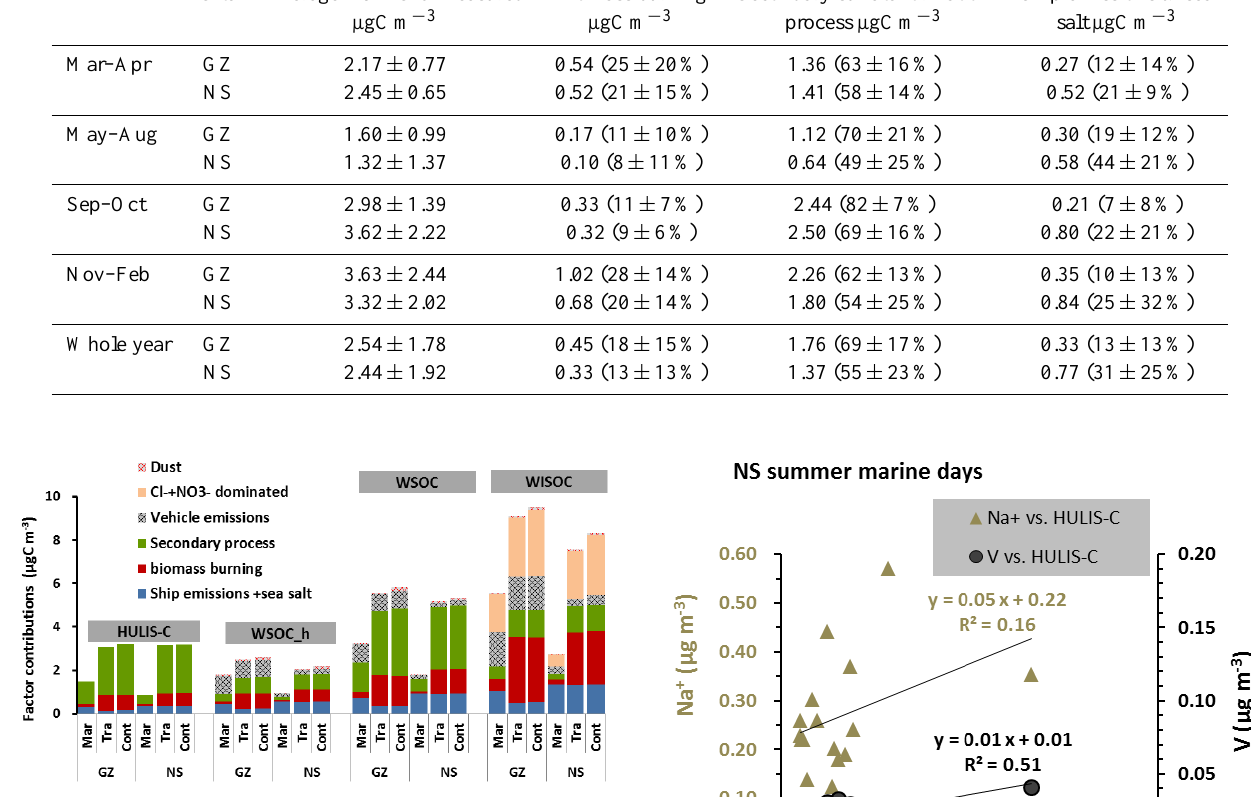
Figure 7. Average source factor contributions to HULIS-C, hy- drophilic WSOC (WSOC_h), WSOC, and water-insoluble organic carbon (WISOC) in samples under influence of different air masses (Mar represents marine; Tra represents transitional; Cont represents continental).